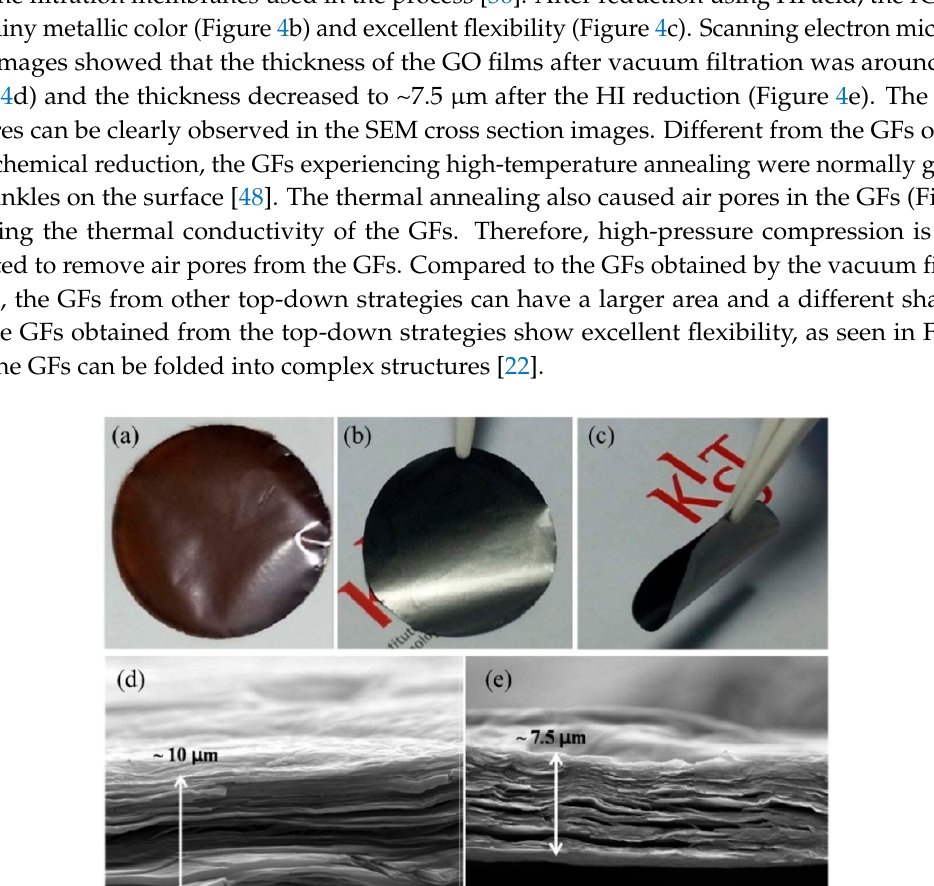
Figure 4. Macro-scale morphology of ( a ) the free-standing dark-brown GO film; ( b , c ) are HI reduced shiny metallic and flexible rGO films; ( d , e ) are cross-sectional SEM images of as-prepared GO and rGO films, respectively. Reprinted from [36] with permission; Copyright 2015 Elsevier.